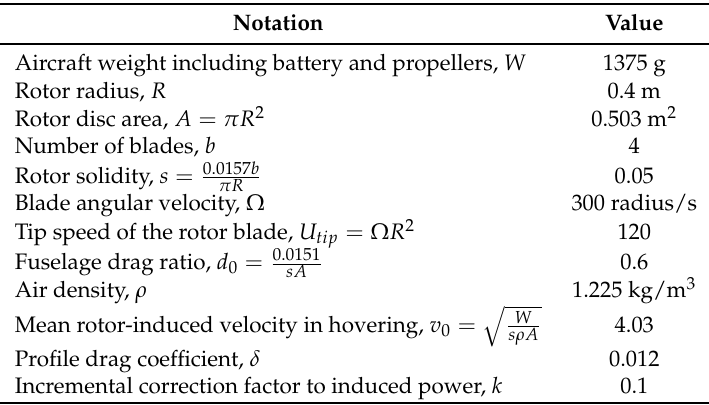
Table 1. Energy-related notation and setup parameters